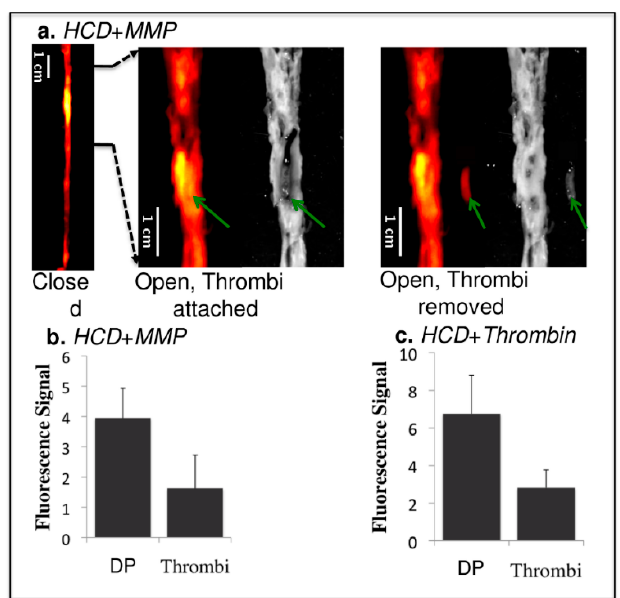
Figure 14. Comparison of fluorescence signals from thrombi and the surrounding atherosclerotic plaque in the experimental group. HCD + MMP-ACPP ( a , b ) and HCD + Thrombin-ACPP(c). The images from left to right in ( a ) are: closed view fluorescence image, opened and zoomed-in fluorescence / reflected images with the thrombus (green arrows) attached at its original site, opened and zoomed-in fluorescence / reflected images with the thrombus removed. The dark signal of the aorta on the reflected image comes from clotted blood and relatively healthy vessel wall (without obvious fatty streaks). Plaques appeared as brighter (grey) signal. The bar graphs ( b , c ) give the statistical analysis of fluorescence signal for the underlying disrupted plaques (DP) and the overlaying thrombi ( p < 0.001). HCD—high cholesterol diet; ACPP—activatable cell penetrating Peptides. Reproduced with permission from Hua et al., 2015 [84].